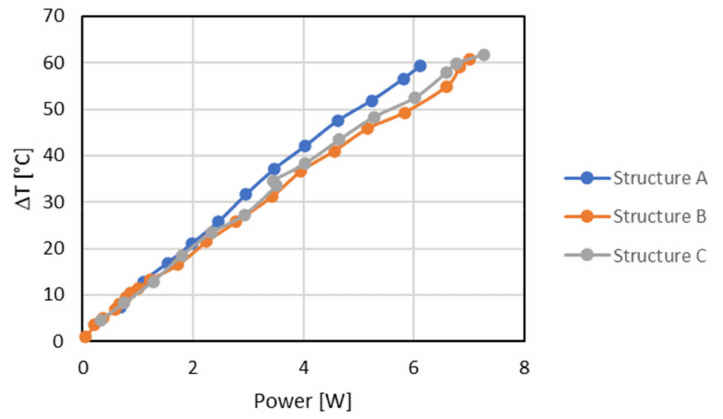
Figure 7. Experimental measurement of ∆ T temperature rise above ambient.